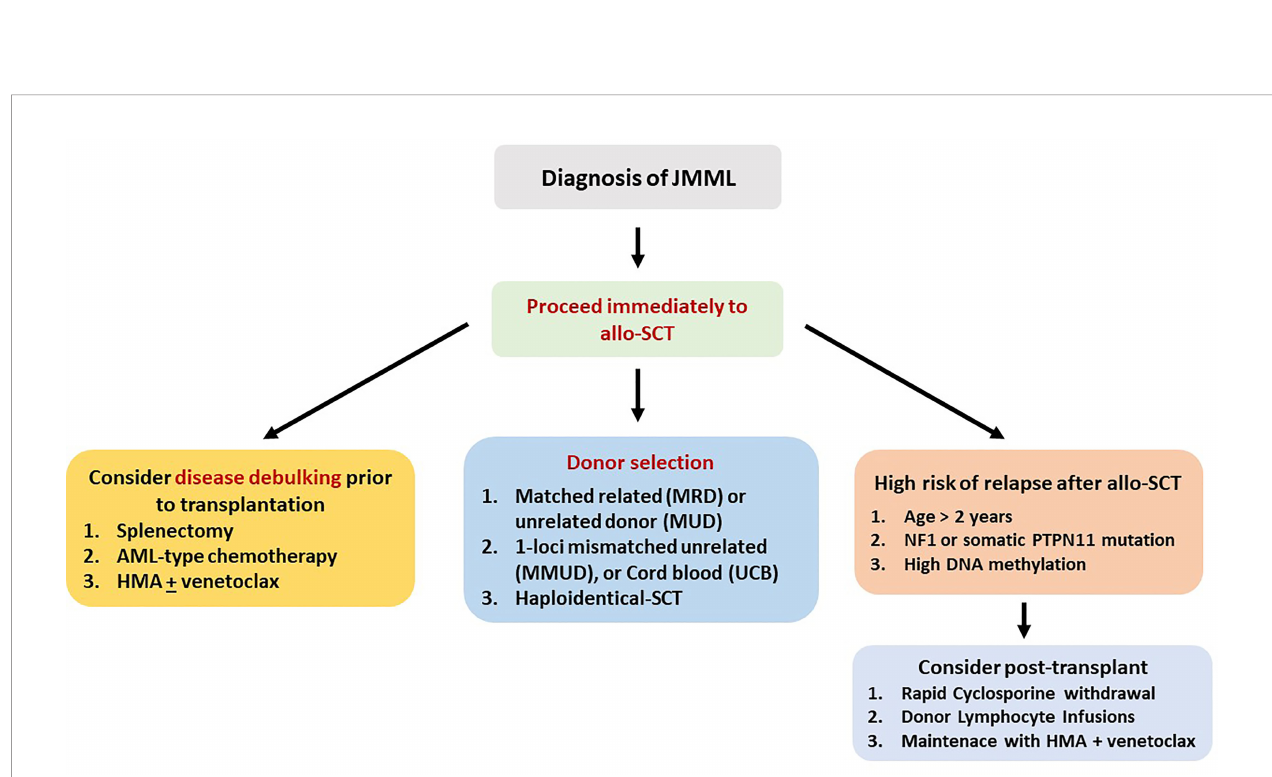
FIGURE 2 | Recommended treatment algorithm for patients with juvenile myelomonocytic leukemia. All patients should be considered candidates for